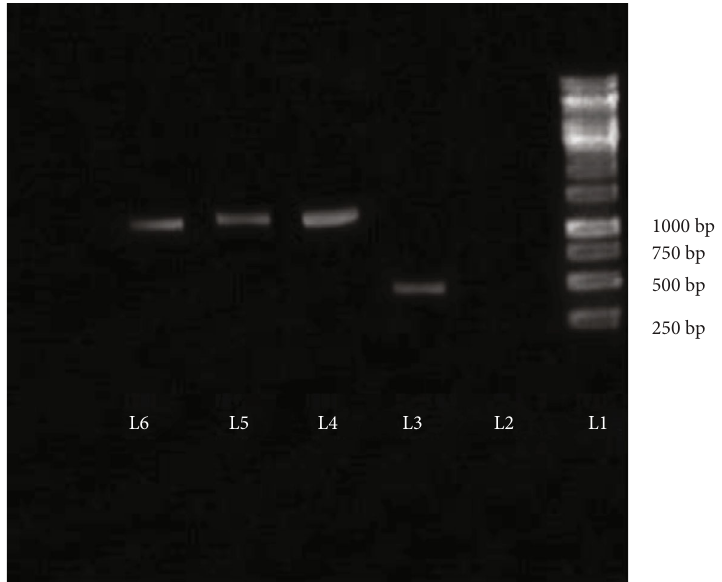
Figure 3: Agarose gel electrophoresis of Ama r 2 PCR products. Lane 1 is a 1kbp Ladder (Fermentase), lane 2 is a negative control, lane 3 is self-plasmid, and lanes 4, 5, and 6 are the products of the direct-colony PCR of the recombinant